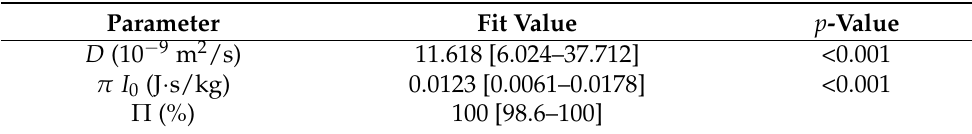
Figure 3. ( A ) Adiabatic invariant versus time (grey points) for a given participant. Lines are added to guide the eyes, and time is expressed in cycle number. ( B ) Typical plots showing the comparison between the theoretical distribution, ρ th ( t i , I ) (solid line), and the experimental distribution, ρ exp ( t i , I ) (histograms), after 50, 150, 250, 350, 400 and 450 cycles for the same participant as in ( A ), with Π = 99.4%. Fitted parameters are equal to π I 0 = 0.0123 J · s/kg and D = 1.05 × 10 − 8 m 2 /s. See text for details. Table 2. Results of the fits of experimental distributions of the adiabatic invariants to model (6). Results are written under the form median [Q1–Q3]. The p -values of the one-sample t -tests are